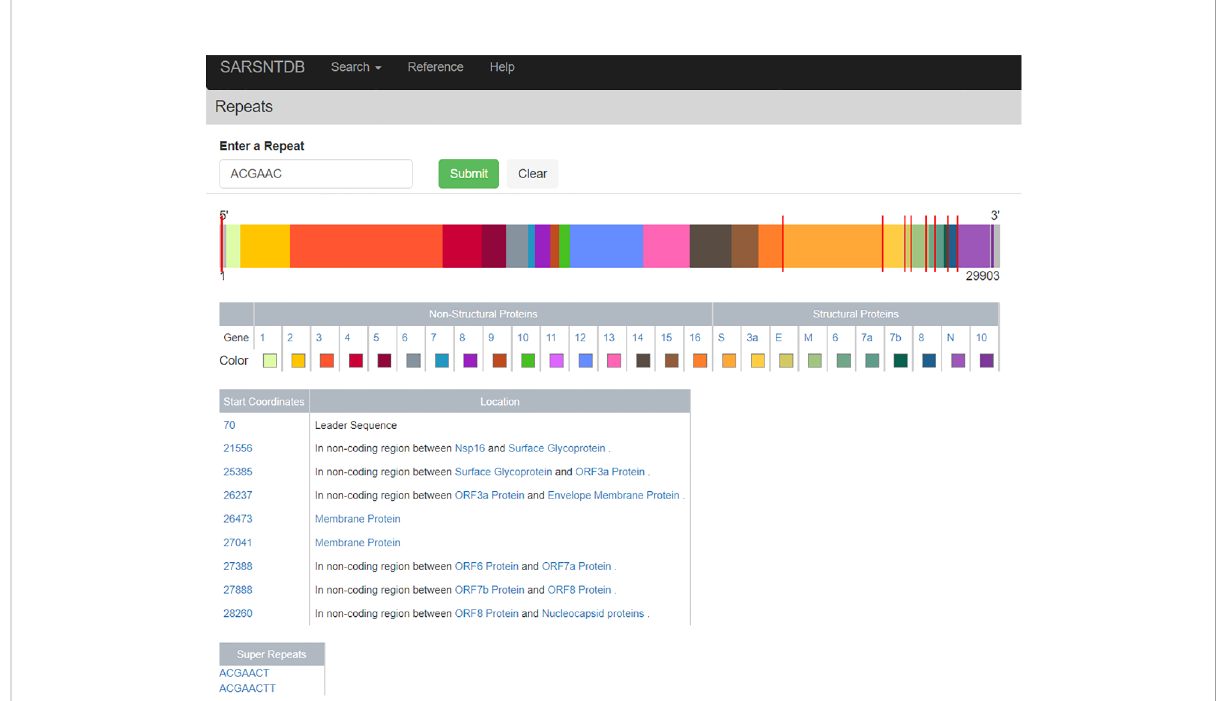
FIGURE 3 Visualization of the leader sequence repeat ACGAAC across the genome. This page visualizes the location of repeats across the genome visible as red ticks on top of the genome. In addition, the locations of repeats within coding regions are listed in a table where each protein name is a link to its genome detail